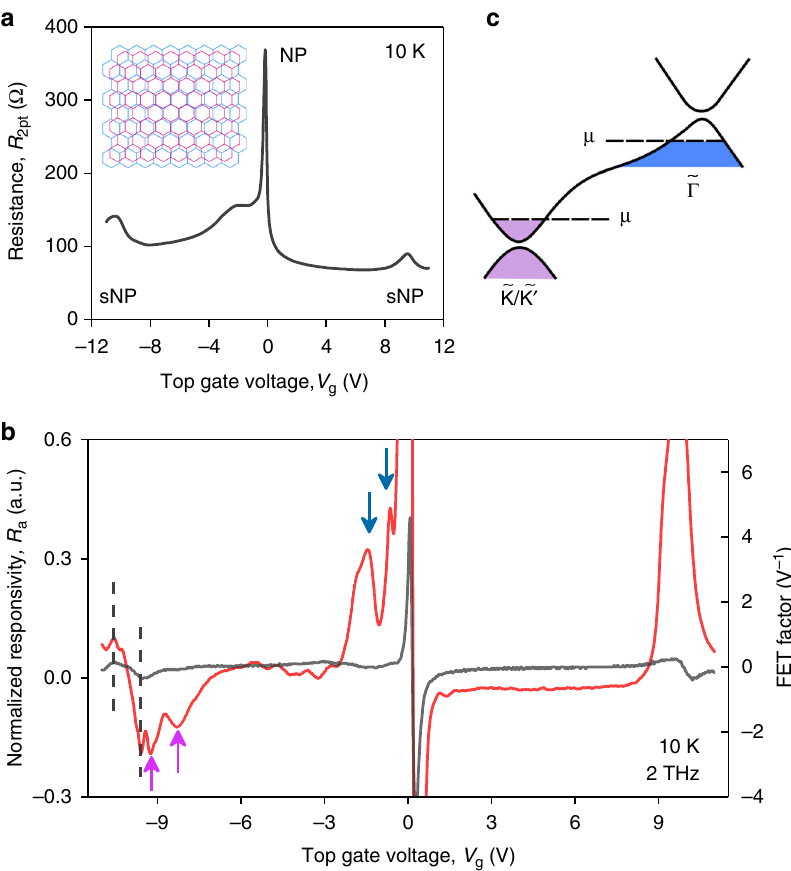
Fig. 4 Miniband plasmons in BLG/hBN moiré superlattices. a Two-terminal resistance of one of our BLG/hBN superlattice devices as a function of V g measured at given T . Inset: illustration of the BLG/hBN superlattice demonstrating a mismatch between graphene and hBN lattice constants. For simplicity, only one graphene layer is shown. b Normalized responsivity (red) and the FET-factor (black) as a function of V g measured in the same device as in a . Dashed lines trace V g where the FET-factor reaches extreme values in the vicinity of the sNP. Pink (blue) arrows point to the resonant peaks near the secondary (main) NP. L = 3 μ m. c Schematic representation of the BLG/hBN superlattice band structure. In the vicinity of the ~ Γ -point (blue), BLG supports propagation of the ordinary plasma waves. Miniband THz plasmons emerge when the chemical potential approaches the sNP